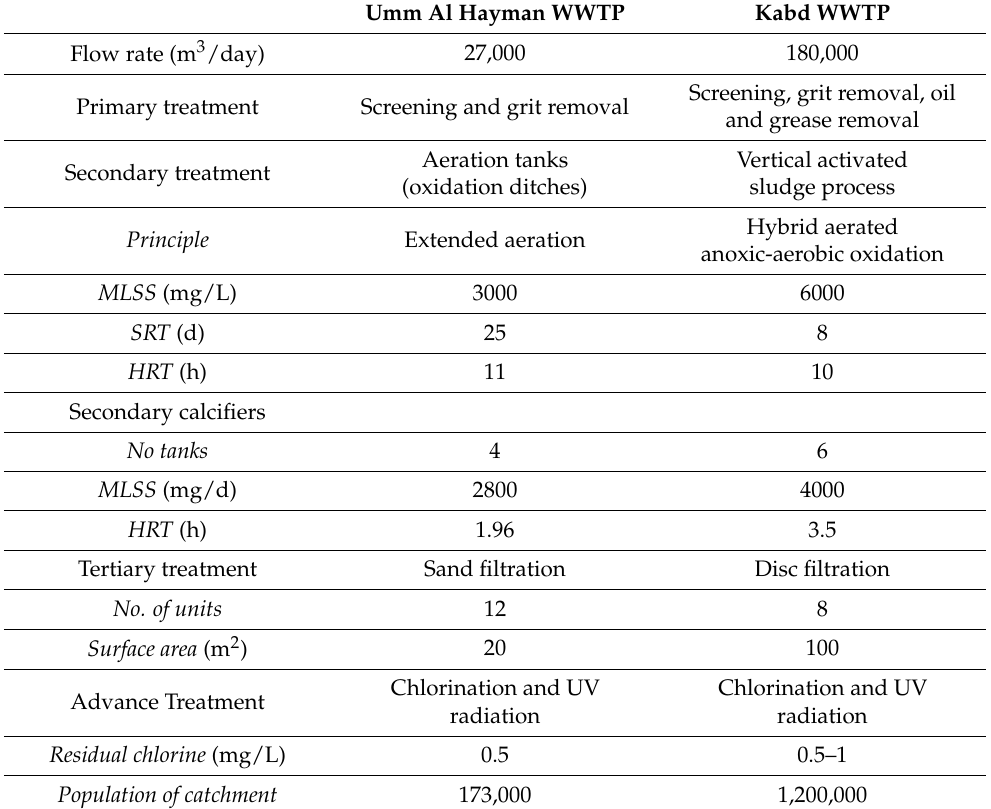
Table 1. Operational parameters of the wastewater treatment plants